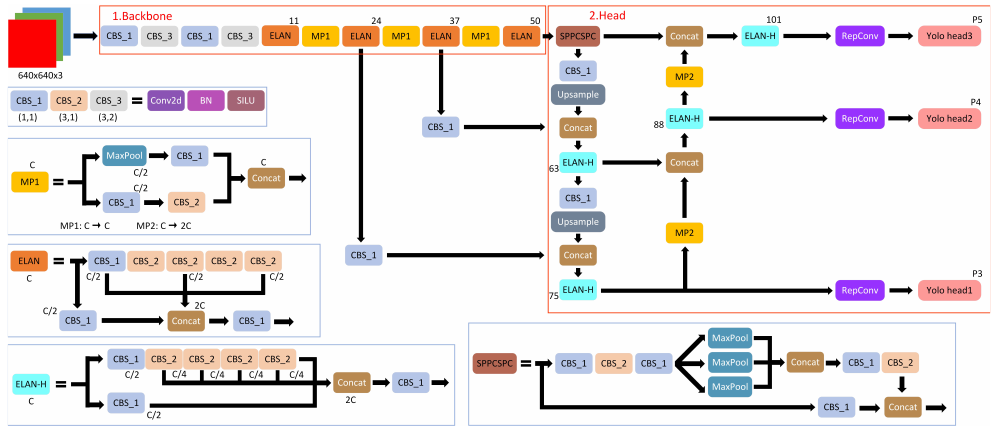
Figure 4. The structure of